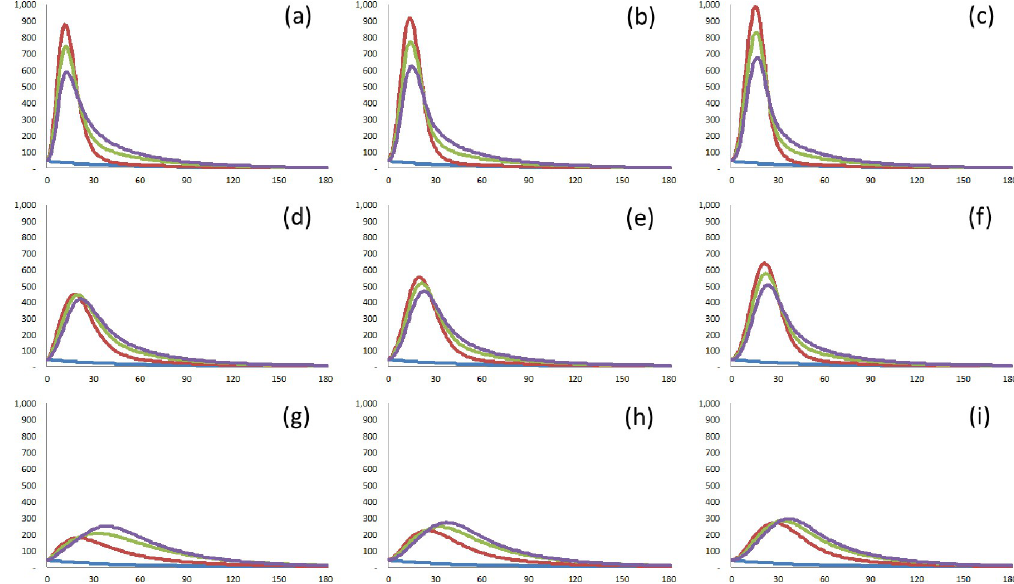
Fig 7. Demonstration of the effects of detection rate. The confirmed cases without a new wave (blue solid line), the confirmed cases with A = 1.0 (red solid line), the confirmed cases with A = 0.75 (green solid line), and the confirmed cases with A = 0.5 (violet solid line). (a) q = 0.4, I med = 3.7. (b) q = 0.4, I med = 5.6. (c) q = 0.4, I med = 7.5. (d) q = 0.2, I med = 3.7. (e) q = 0.2, I med = 5.6. (f) q = 0.2, I med = 7.5. (g) q = 0.1, I med = 3.7. (h) q = 0.1, I med = 5.6. (i) q = 0.1, I med = 7.5.